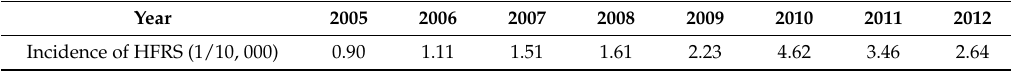
Table 2. Annual incidence of hemorrhagic fever with renal syndrome (HFRS) from 2005 to